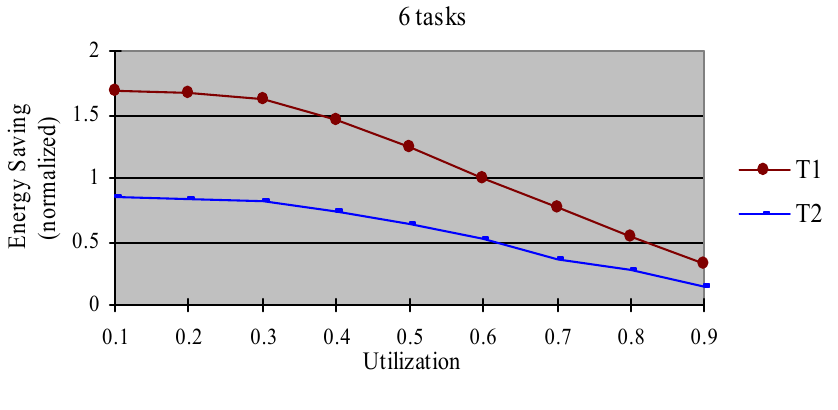
Figure 7. Normalized weighted energy consumption when using different energy-saving